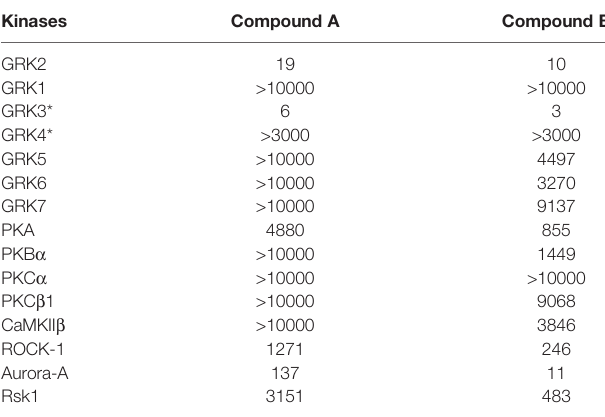
TABLE 1 | Kinase activity pro fi le of Compound A and B against GRK2, GRK1, GRK3, GRK4, GRK5, GRK6, GRK7, and other kinases.